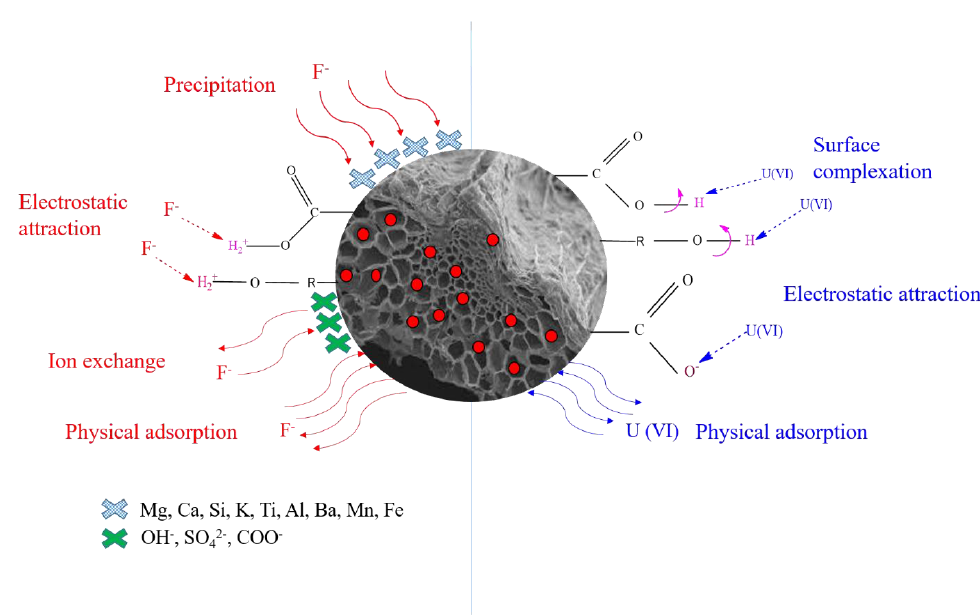
Figure 5. Schematic representation of major mechanisms of U and F − adsorption on biochar surface.